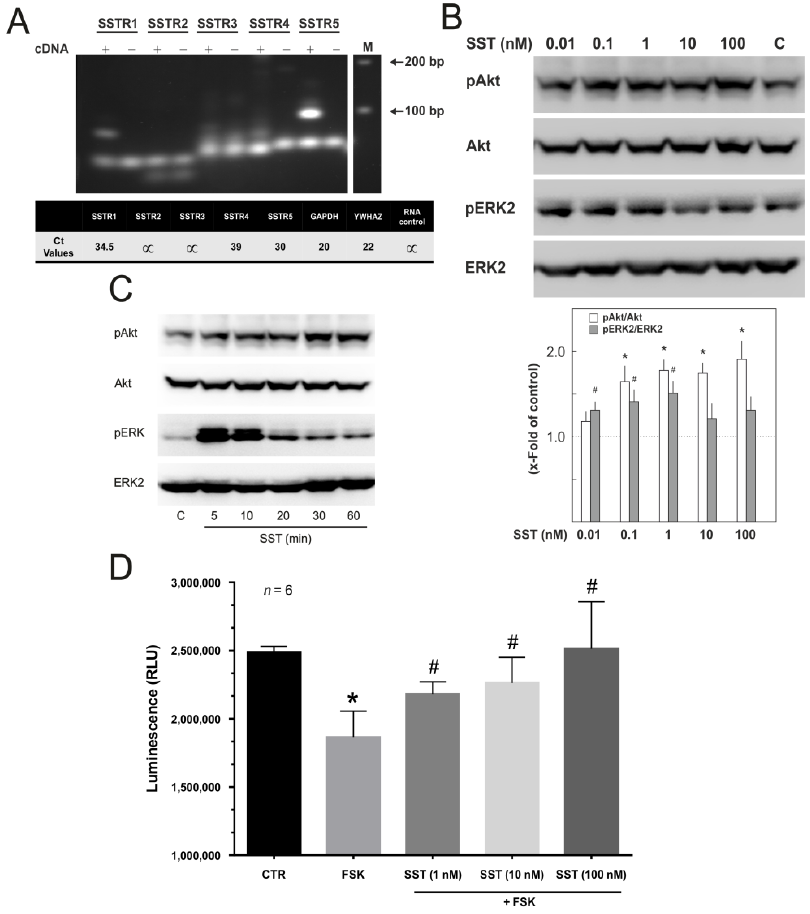
Figure 1. SST receptor gene (SSTR) expression and signalling in HUVECs . ( A ) The expression of SSTR mRNAs in HUVECs. The expected PCR fragment sizes for SSTR1-5 were 115 bp, 193 bp, 151 bp, 157 bp, and 94 bp, respectively. The plus (+) sign indicates cDNA and negative (-) sign indicates total RNA (without reverse transcriptase) used as the negative control. The lower panel shows Ct values determined by qPCR using HUVEC cDNA corresponding to 1 ng total RNA. ( B ) Concentration (as indicated)-dependent effect of SST14 on Akt and ERK2 phosphorylation. C: buffer-treated control. Representative Western blots of 3 experiments. The lower panel shows the quantification of the Western blots shown above, the dotted line shows the normalised basal levels of pAkt and pERK2. n = 3, p < 0.05; * vs. control (pAkt), # vs. control (pERK2). ( C ) Time-dependent effect of SST14 (1 nM) on Akt and ERK2 phosphorylation. Representative Western blots of phosphorylation and total Akt and ERK. ( D ) Concentration-dependent effect of SST14 (1 nM) on FSK-induced cAMP production. ECs were treated with SST14 or buffer (CTR) for 10 min followed by treatment with FSK (10 µ M). n = 6, p < 0.05; * vs. control, # vs. FSK